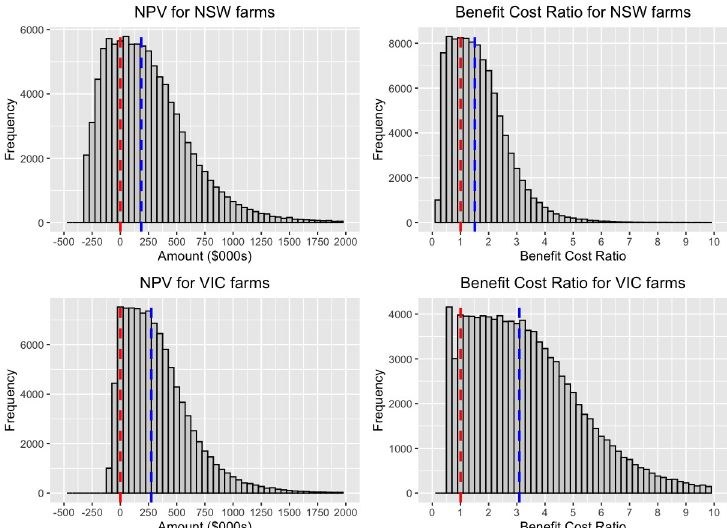
Fig 2. Net Present Value (NPV) and Benefit Cost Ratio (BCR) of renovating dams on beef cattle farms in NSW and Victoria. The blue dashed line is the median. In the NPV plots, the red dashed line marks the point where the NPV equals 0. In the BCR plots, the red dashed line marks the point where PV of benefits equals PV of costs.